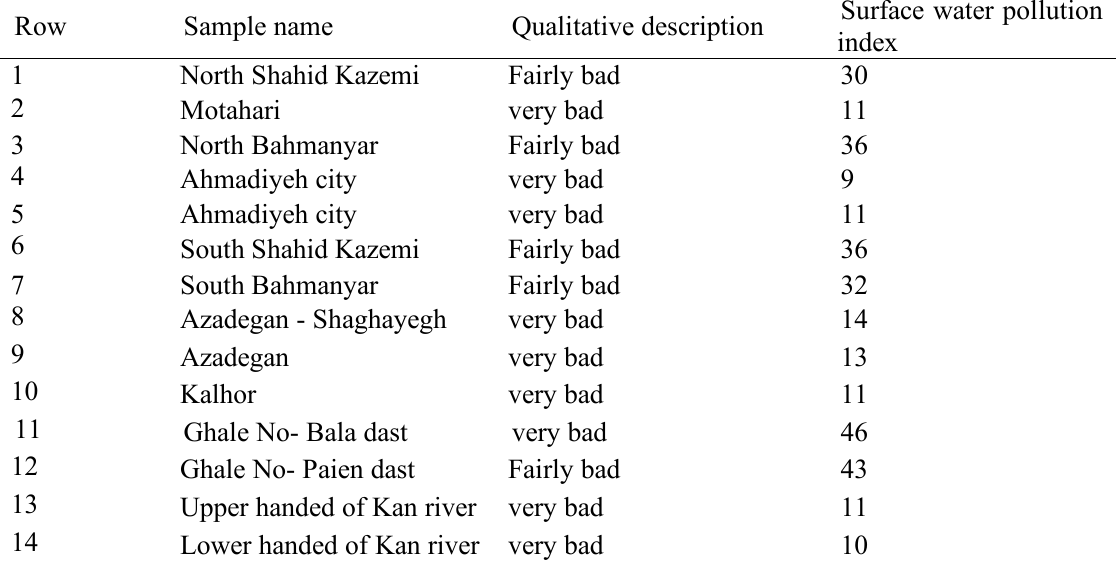
Table 9 . Contamination of surface water index for samples